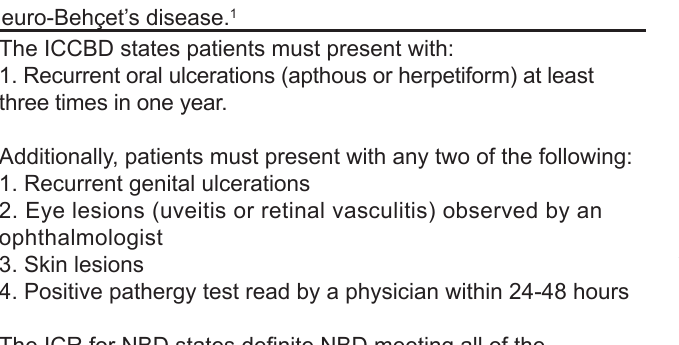
Table. International Consensus Recommendation criteria for neuro-Behçet’s disease. 1